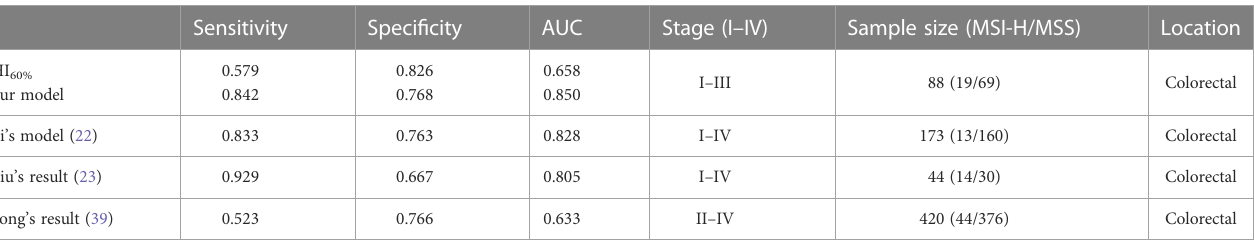
TABLE 4 PET/CT for predicting